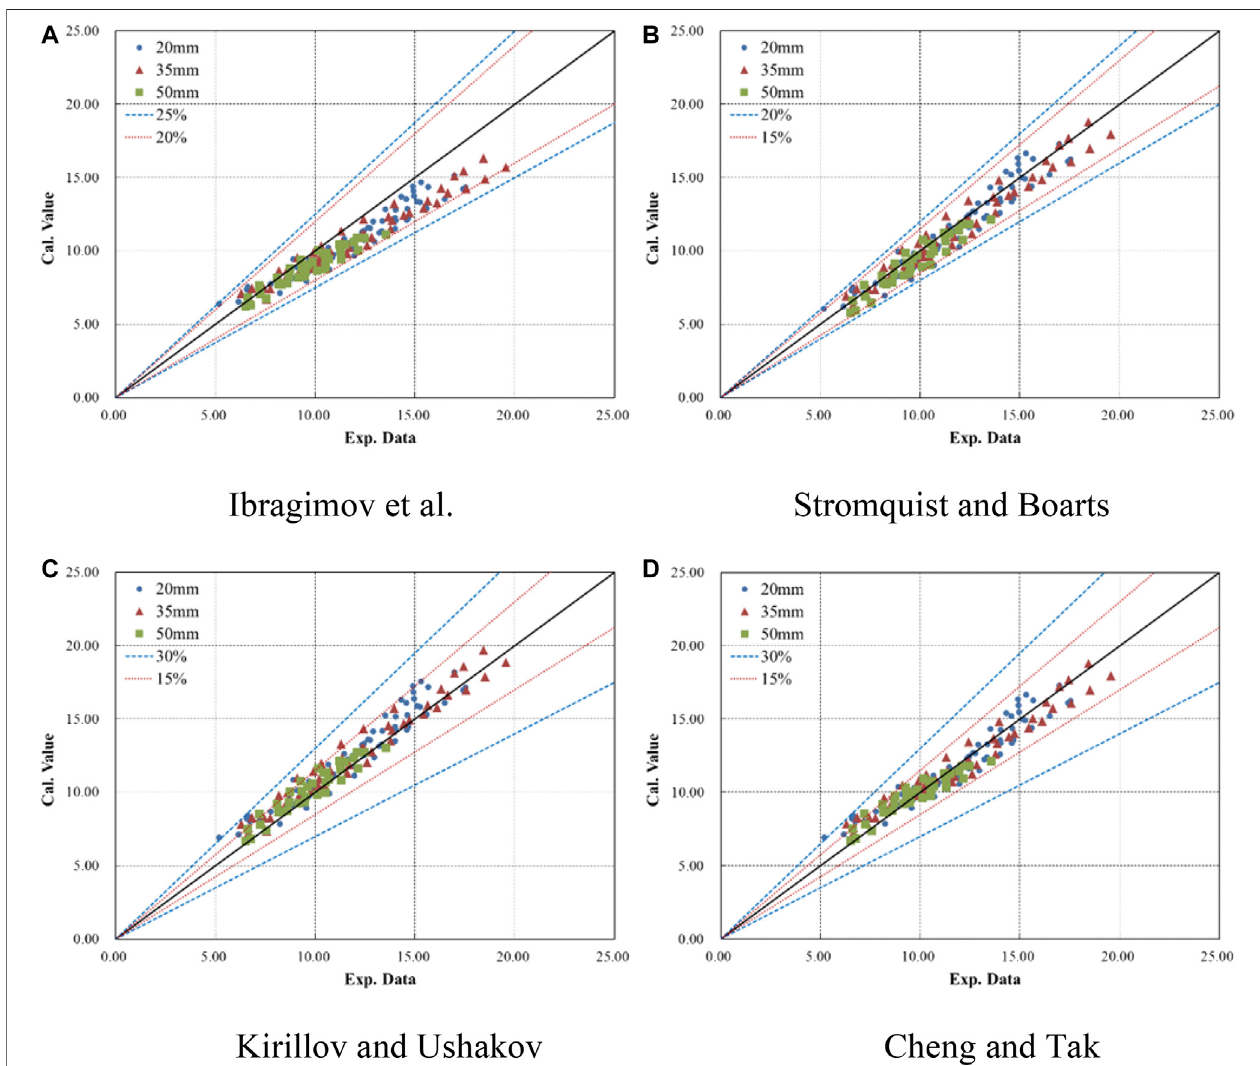
FIGURE 11 | Deviations of other relations from the NCCL experimental